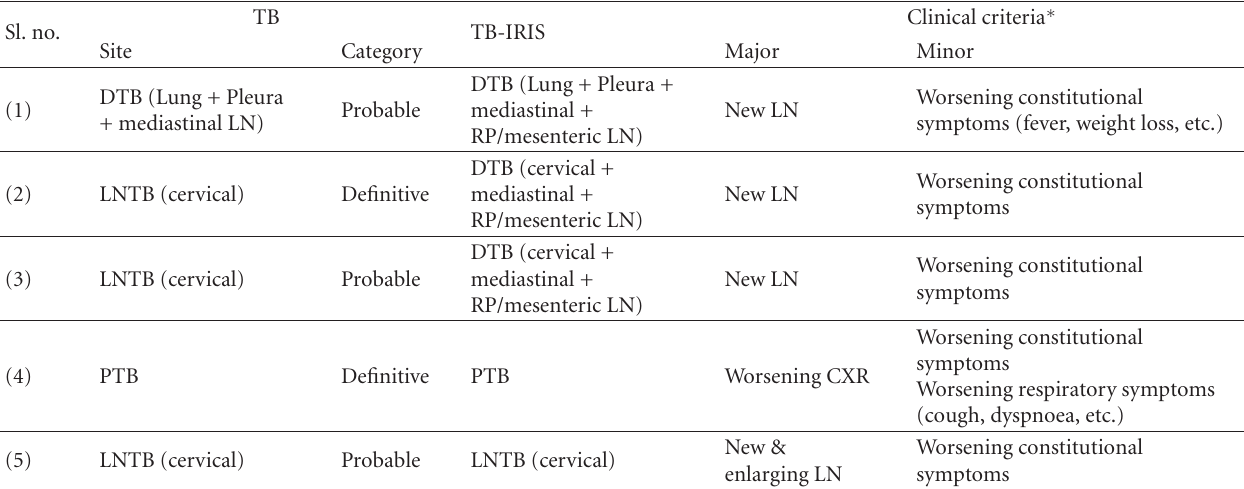
Table 4: Diagnosis of paradoxical TB-IRIS according to consensus case-definition.